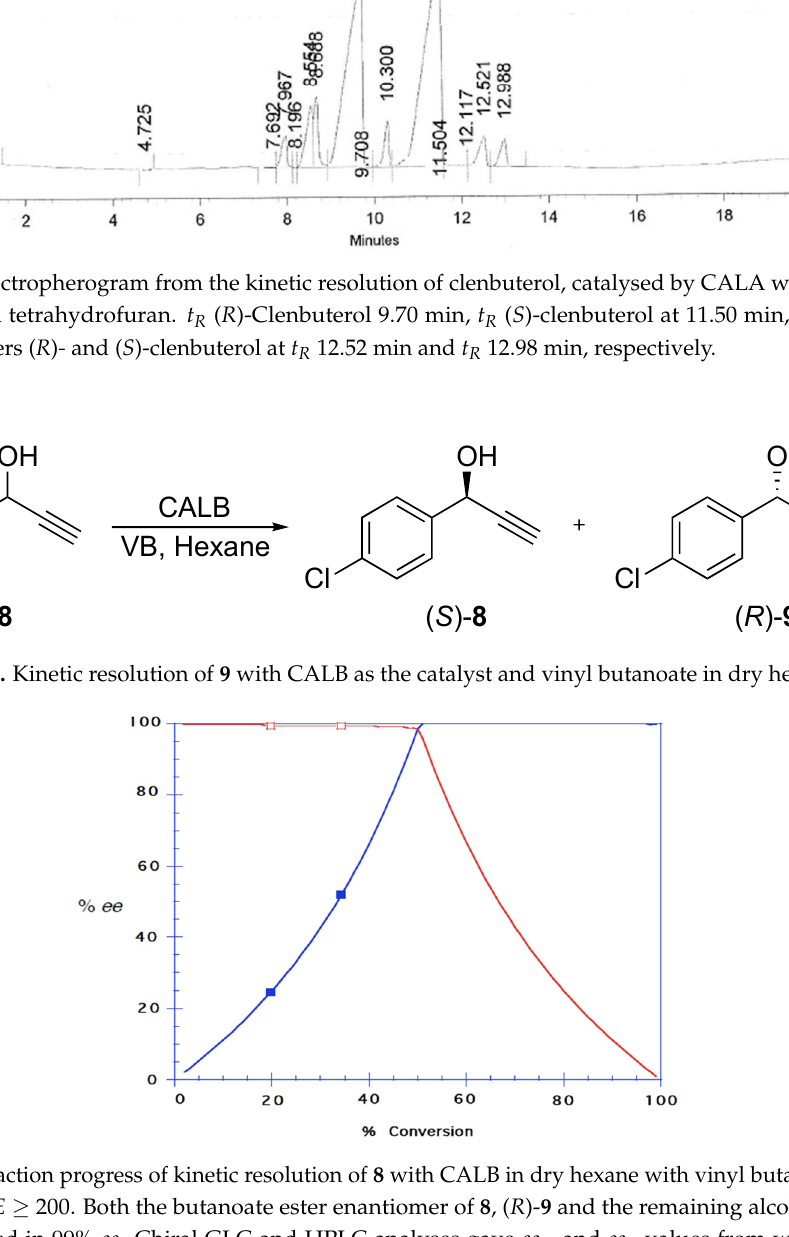
Figure 2. Electropherogram from the kinetic resolution of clenbuterol, catalysed by CALA with vinyl butanoate in tetrahydrofuran . t R ( R )‐Clenbuterol 9.70 min, t R ( S )‐clenbuterol at 11.50 min, and the butanoic esters ( R ) - and ( S )‐clenbuterol at t R 12.52 min and t R 12.98 min, respectively.